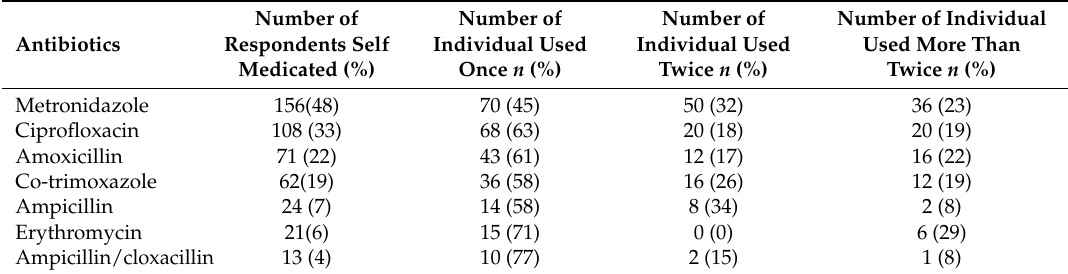
Table 2. Frequency of antibiotics that are self-medicated by non-medical university students in Southern Punjab.